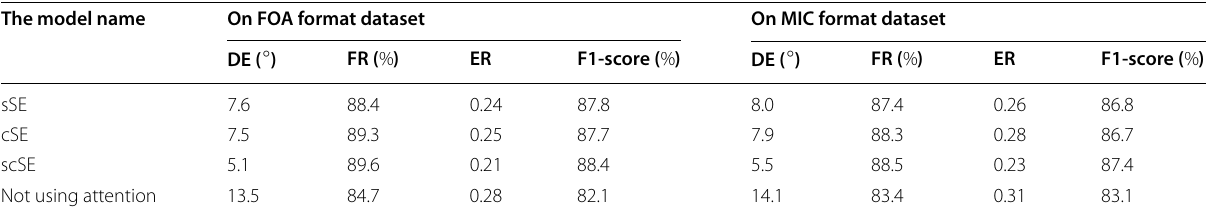
Table 4 Model performance comparison under different attention mechanisms based on FOA and MIC format dataset The model